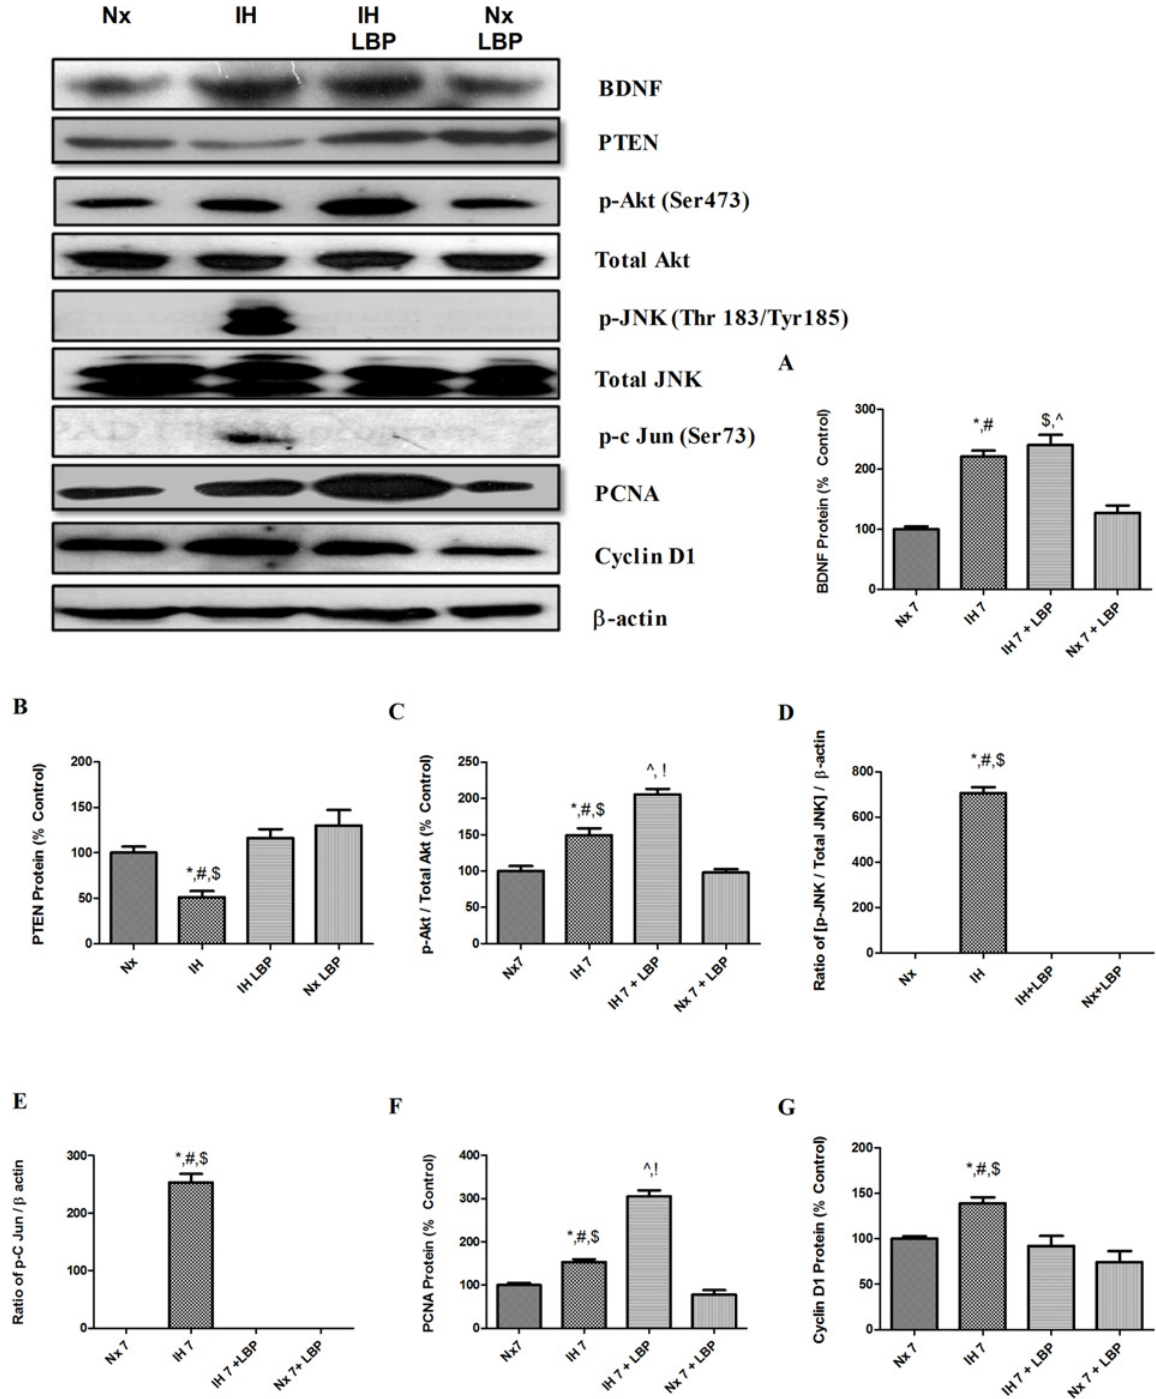
Fig 10. LBP facilitated CIH-activated hippocampal regeneration through Akt/PCNA axis. Levels of the protein expression (upper panel) of (A) BDNF (B) PTEN, (C) p-Akt, (D) p-JNK, (E) p-c Jun, (F) PCNA and (G) cyclin D1 in the hippocampus of the normoxic (Nx) or hypoxic (IH) groups; LBP-treated hypoxic (IH+LBP) or normoxic (Nx+LBP) groups are summarized. For BDNF, * p < 0.05 when compared with Nx groups, # p < 0.05 when compared with Nx+LBP groups, $ p < 0.05 when compared with Nx groups, ^ p < 0.05 when compared with Nx +LBP groups. For PTEN, p-JNK, p-c Jun and cyclin D1, * p < 0.05 when compared with Nx, # p < 0.05 when compared with IH+LBP, $ p < 0.05 when compared with Nx+LBP groups. For Akt and PCNA, * p < 0.05 when compared with Nx groups, # p < 0.05 when compared with IH+LBP groups P, $ p < 0.05 when compared with Nx+LBP groups, ^ p < 0.05 when compared with Nx, ! p < 0.05 when compared with Nx+LBP